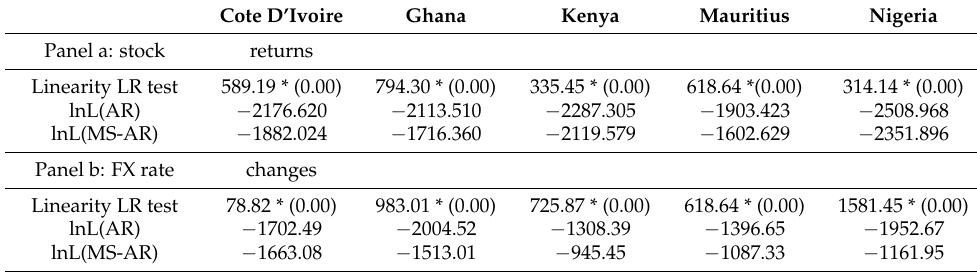
Table 7. LR test